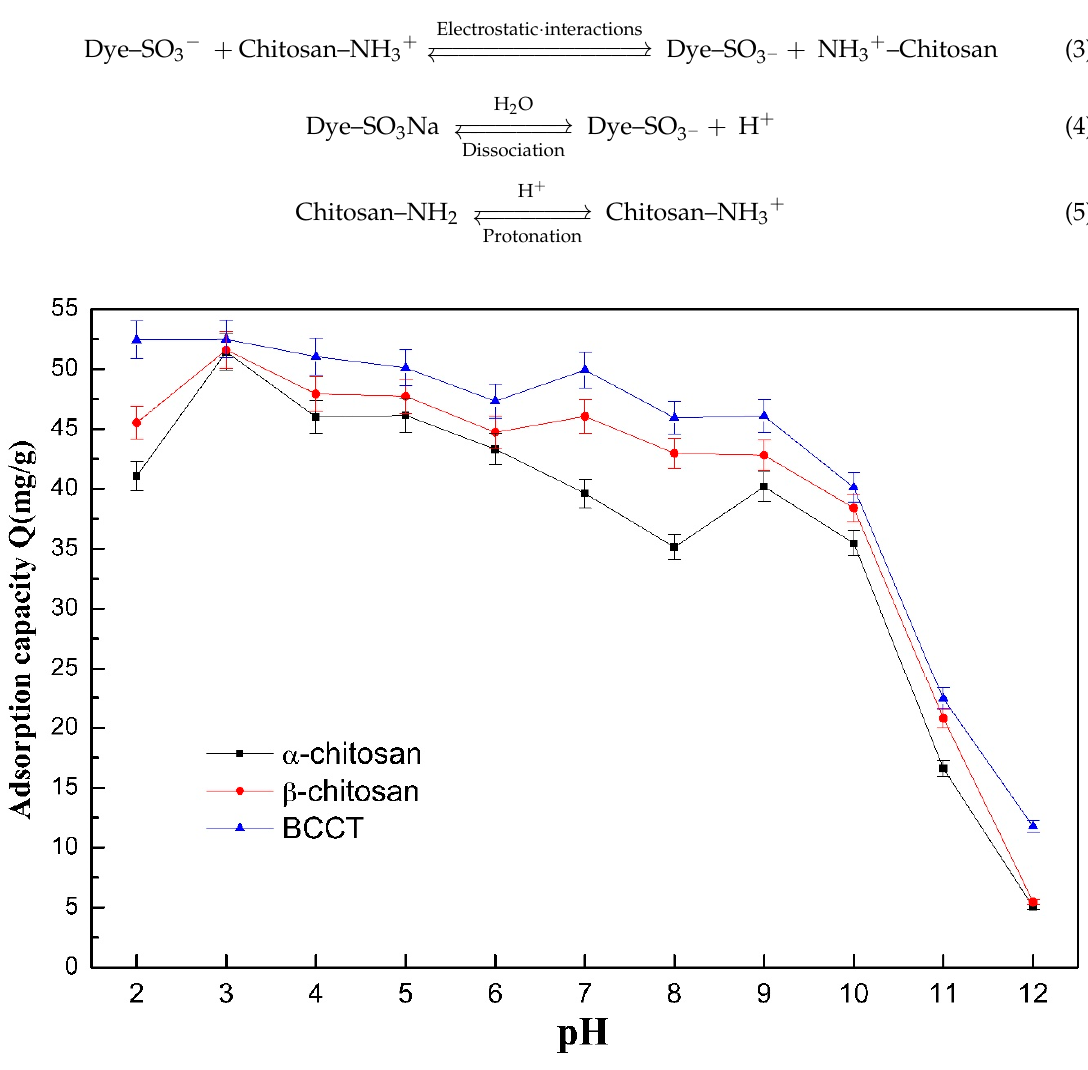
Figure 3. Effects of the pH change on the adsorption capability of the adsorbents.